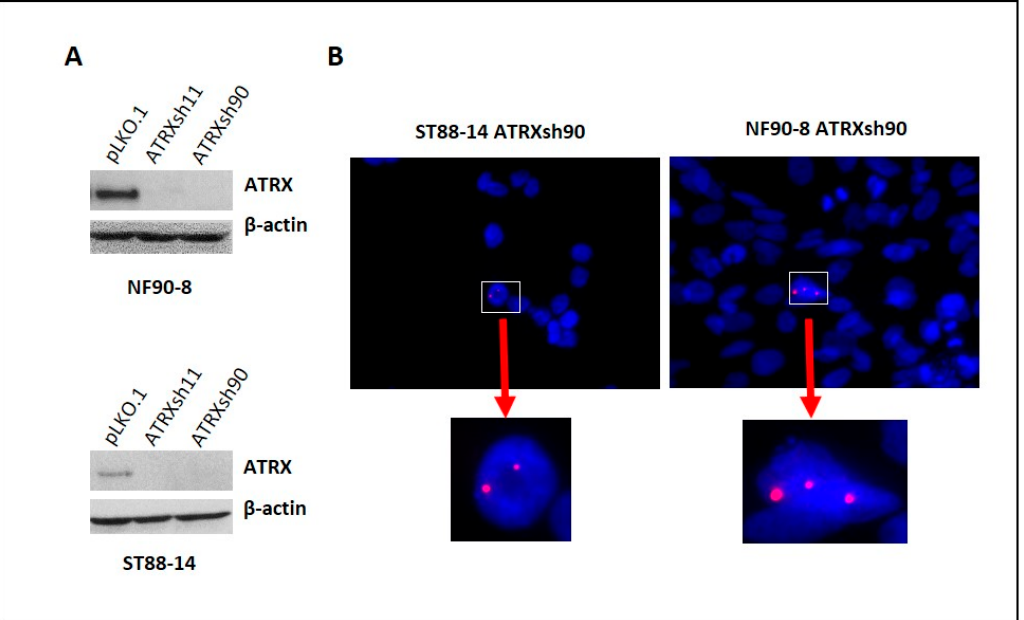
Figure 4. ATRX knockdown resulted in rare abnormal telomere FISH signals: Reduction in ATRX expression using ATRX shRNAs in NF90-8 and ST88-14 MPNST cell lines ( A ), empty lentiviral vector (pLKO.1) was used as control. Development of ultrabright telomere foci reminiscent of ALT was detected with telomere FISH after ATRX knockdown ( B ).